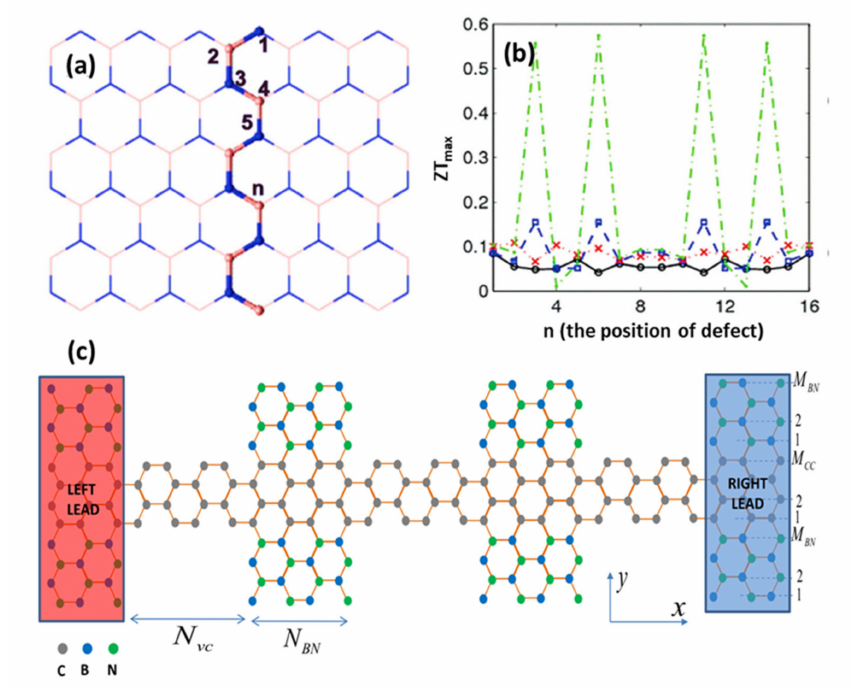
Figure 8. Schematic of ZBNNR ( a ) with different defect sites to be considered, which are labeled by the number 1, 2, 3, n. ( b ) The ZT max as a function of the position of defect n for N A (N Z ) = 8. The solid, dashed, dotted, and dotted dashed curve corresponds to the ZGNR, AGNR, ZBNNR, and ABNNR, respectively [128] (Reprinted with permission from AIP Publishing, Copyright © 2013). ( c ) Schematic view of graphene/BN heterostructure with subsections made of BN flakes attached to the main AGNR channel. The two leads are made of BN/G/BN ribbons as the hybrid parts of the active device [129] (Reprinted with permission from IOP Publishing, Ltd., Copyright ©